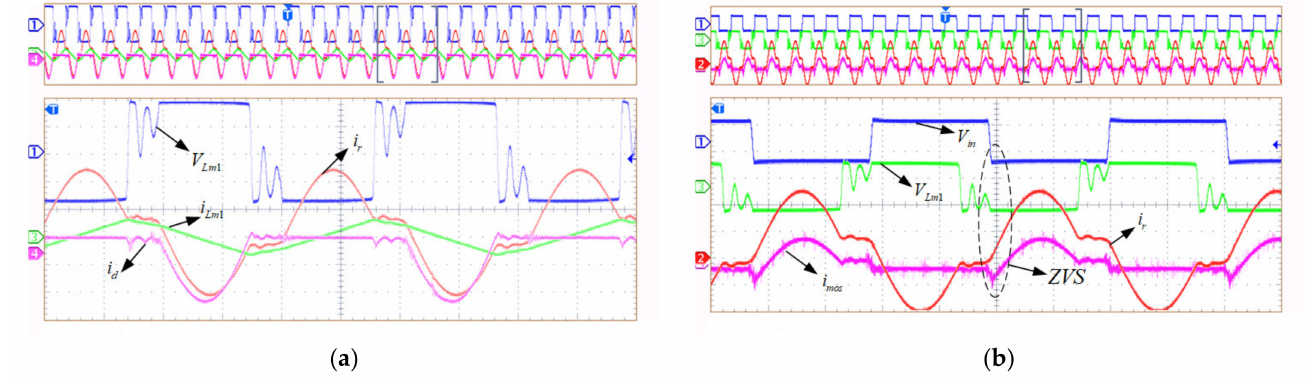
Figure 15. Experimental waveform when switching frequency is less than the resonant frequency, and ( a , b ) show the corresponding current of the diode and low-voltage side MOS tube, respectively.